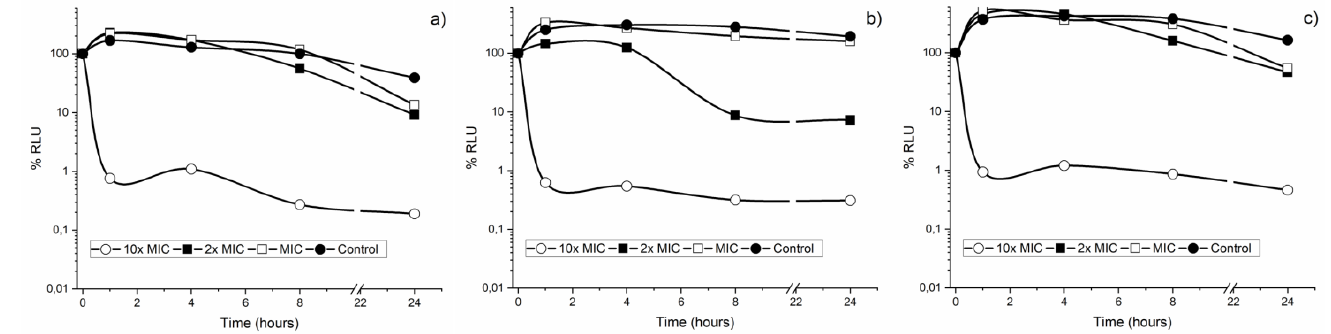
Figure 4. Variation of metabolic activity of the S. mutans ( a ), S. sanguinis ( b ) and mixture of both strains ( c ) included in mature biofilm under various concentrations of CAR and Control (no treatment) at different